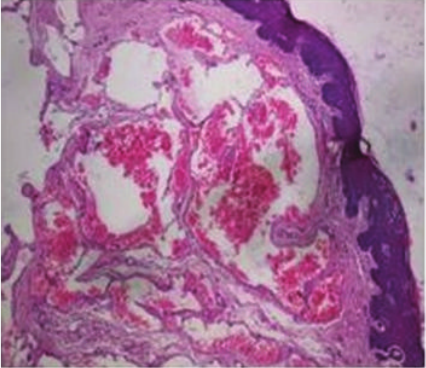
Figure 8: Histopathological